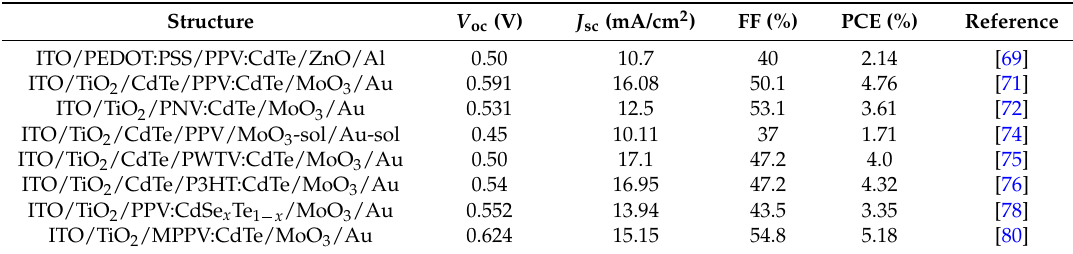
Table 1. Selected performance parameters of HSCs (hybrid solar cells) based on aqueous-processed polymer NCs (nanocrystals).